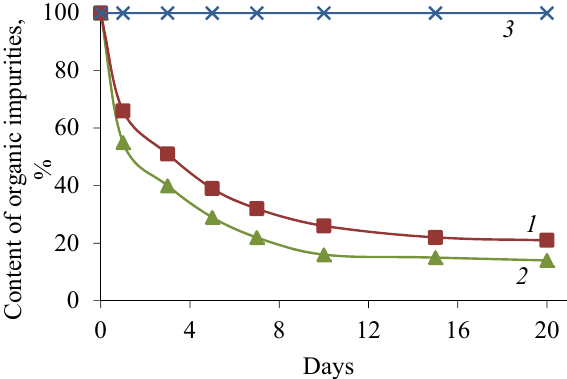
Fig. 2. Change in the content of trichlorethylene ( 1 ), dichloroethane ( 2 ) and chloroform ( 3 ) in water in the presence of sodium benzoate over time.